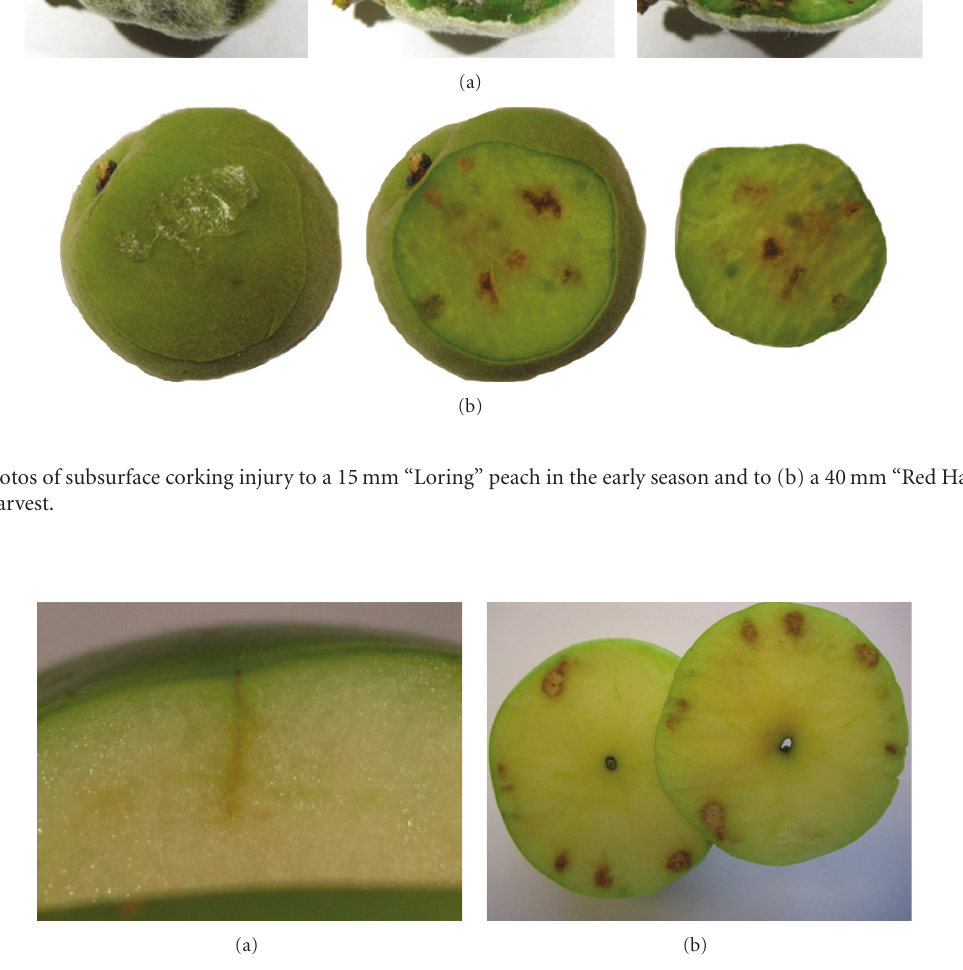
Figure 3: (a) Photo of subsurface feeding sheath that is the result of feeding in the early season on “Golden Delicious” apple and of (b) subsurface corking injury on “Turley Winesap” which is the result of feeding taking place later in the season (from ∼ 6–8 weeks after petal fall until